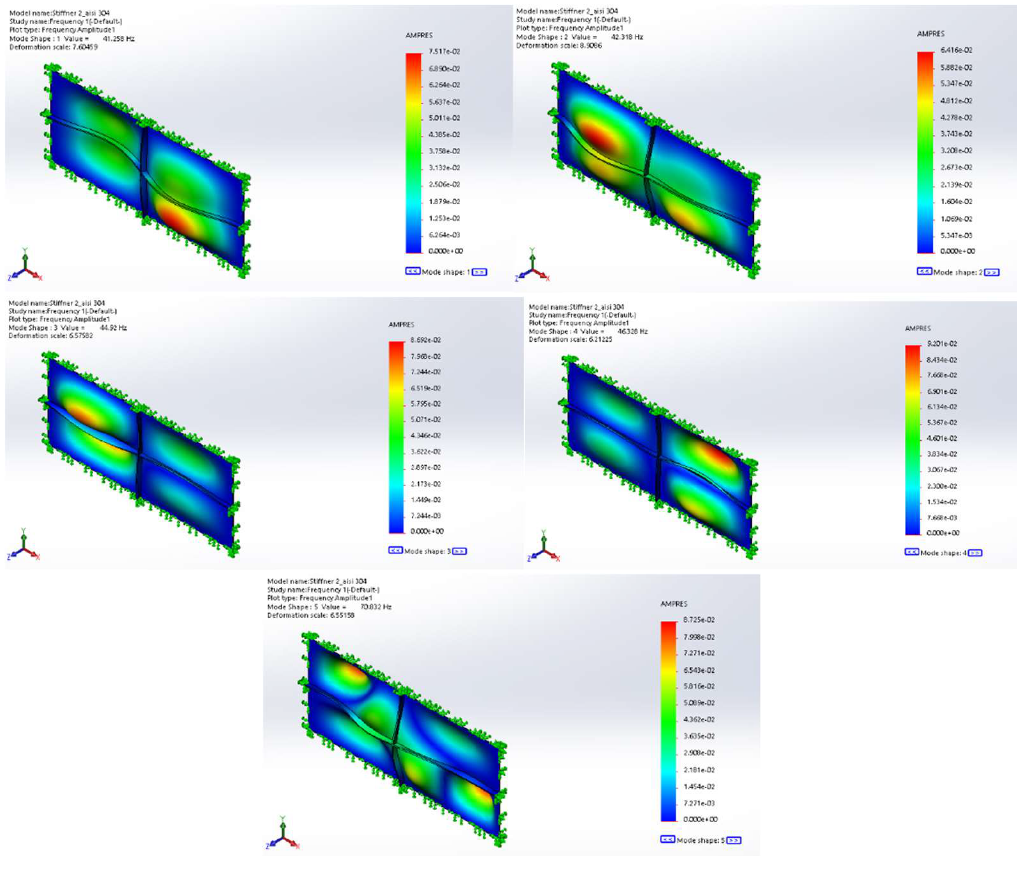
Figure 32: Mode shapes 1–5 of the flat wall with a cross stiffener